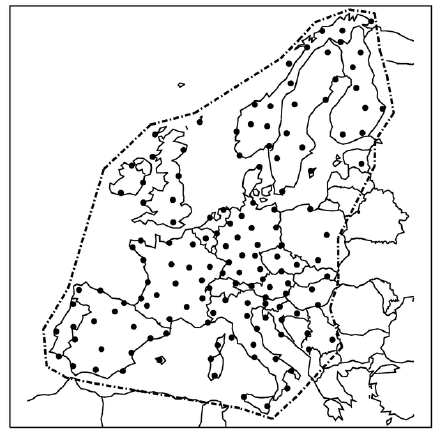
Figure 1. Sensor locations within the EUCLID network. Note that only data within the polygon (dashed–dotted line) is used for quan- titative analysis in this